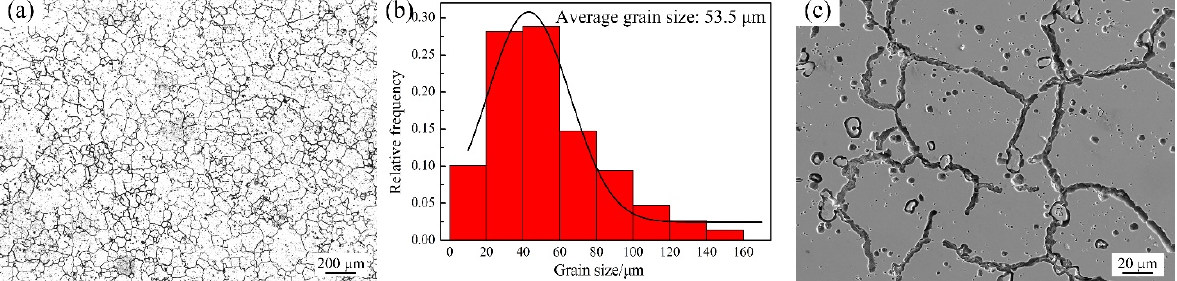
Figure 2. Microstructure of the as-received GH3536 alloy: ( a ) OM image, ( b ) histogram of grain size distribution, and ( c ) SEM image.